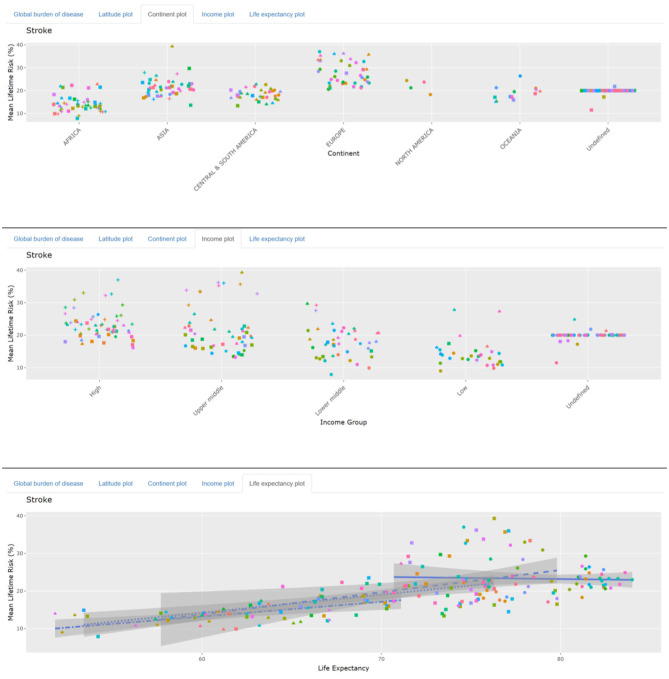
Lifetime risk of stroke vs. continent, economy, and life expectancy. On the web, the plots of lifetime risk by latitude, continent, income, and life expectancy are interactive, and the reader can hover over the data point to obtain similar information on each country. The top figure shows relationship between lifetime risk of stroke and countries grouped by continent, with risk highest in Europe and lowest in Africa. The middle figure shows decreasing trend in lifetime risk of stroke from high- to low-income countries. The lower figure shows that the relationship between lifetime stroke risk and life expectancy was β = 0.48 ± 0.047; 95% CI = 0.390–0.574; R2 = 0.380; p < 0.01. Subgroup analysis indicated that this relationship was strong for low-income countries (p < 0.01), and the relationship flattened out for high-income countries (p = 0.8).